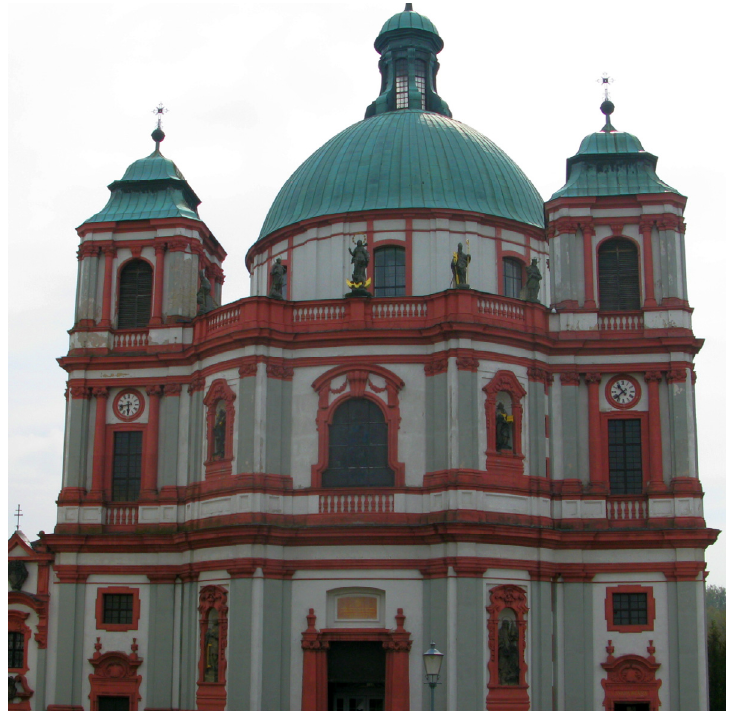
Figure 11. The colorful façade of the monastery church in Jablonné (Gabel, 1699), designed by J.L. von Hildebrandt. Photo from private collection.